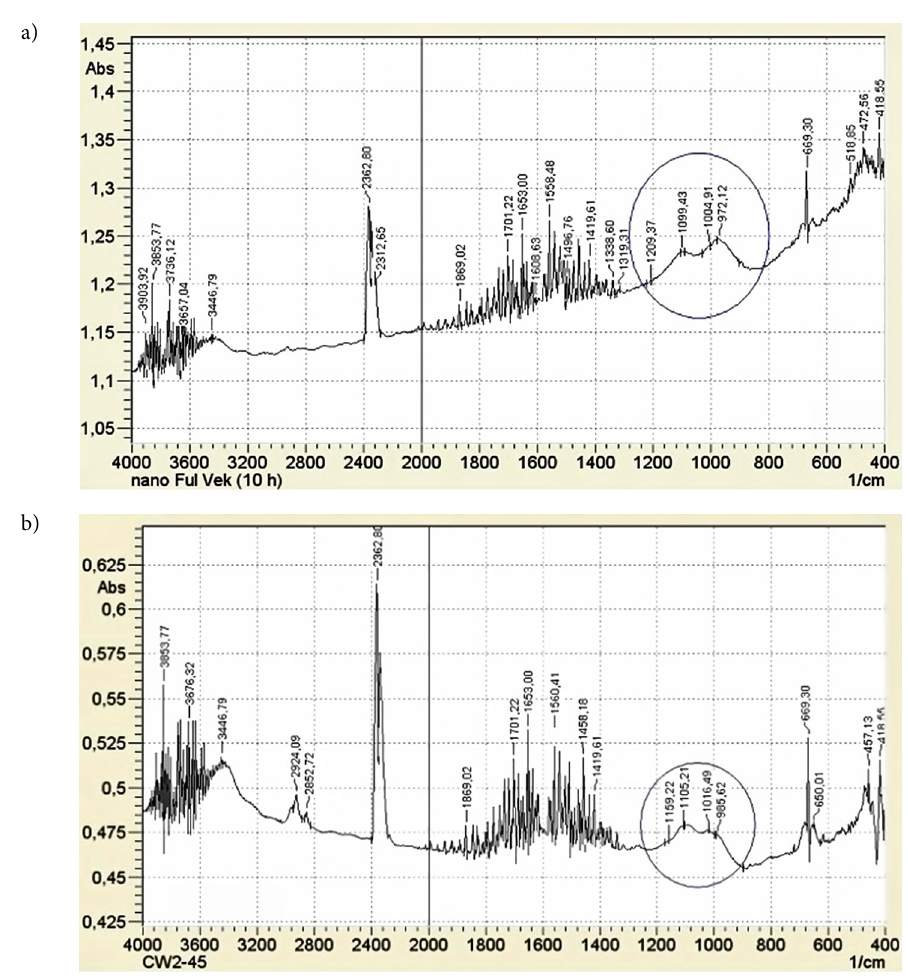
Fig. 3. IR spectrum: a – of suspension treated for 10 hours; b – of Masterbatch CW 2-45